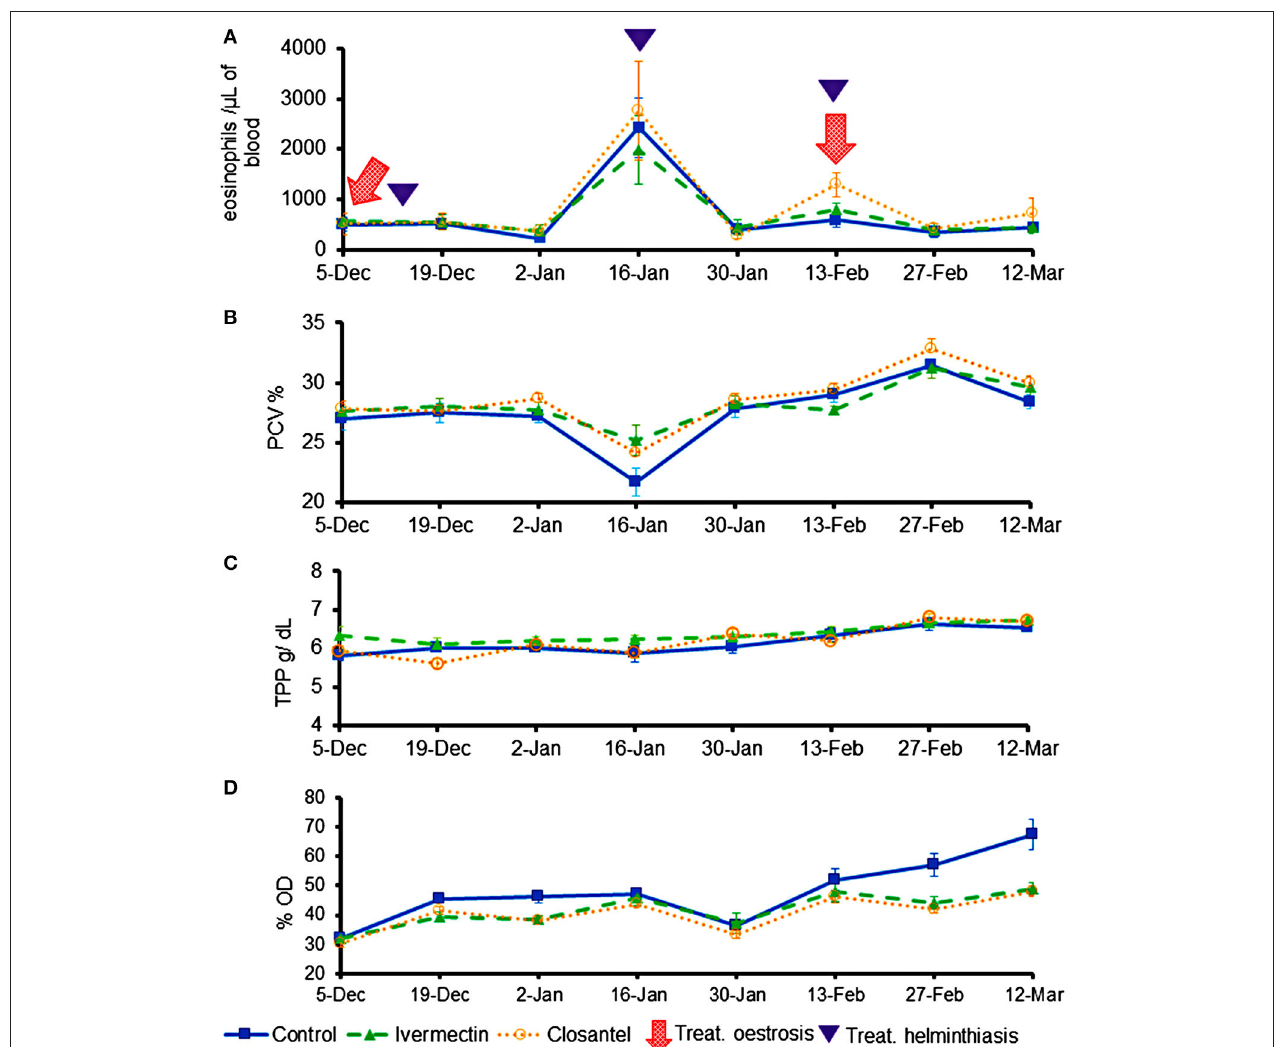
FIGURE 4 | Averages ( ± standard error) of eosinophils (cells/ µ L) (A) , packed cell volume (%) (B) , total plasma protein (g/dL) (C) , and optical density (%OD) of IgG anti- O. ovis L2 (D) of lambs treated with ivermectin or closantel. The moments of treatments against oestrosis (with ivermectin or closantel) are indicated by arrow and treatments against helminthiasis (with a combination of levamisole + albendazole + monepantel) are indicated by